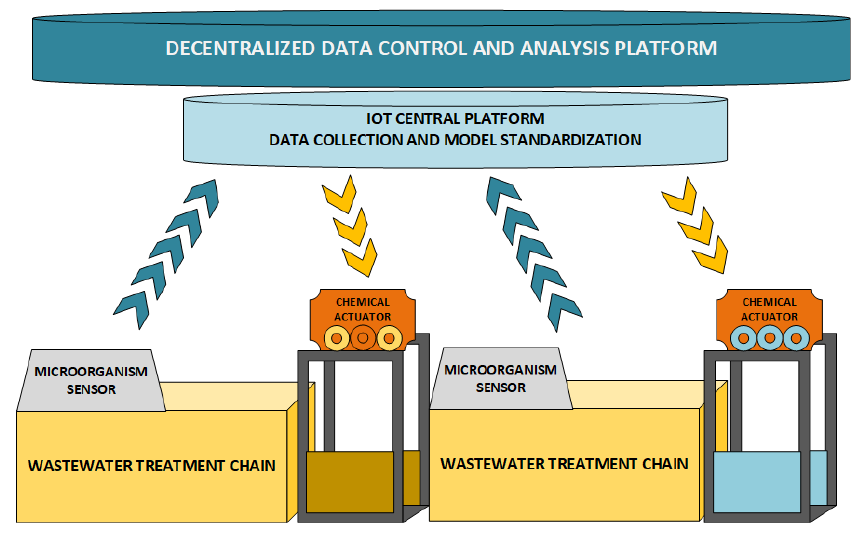
Figure 4. Chemical level management